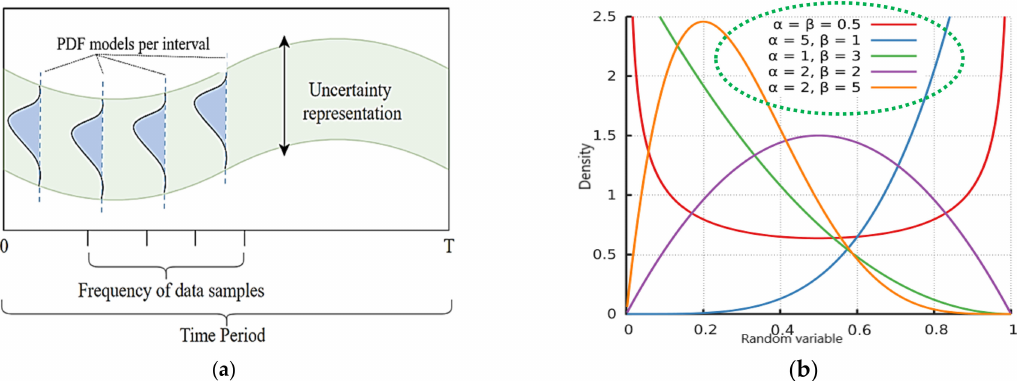
Figure 2. Illustrating uncertainty representation ( a ), the variation in beta probability distribution function curves with different shape parameters ( b